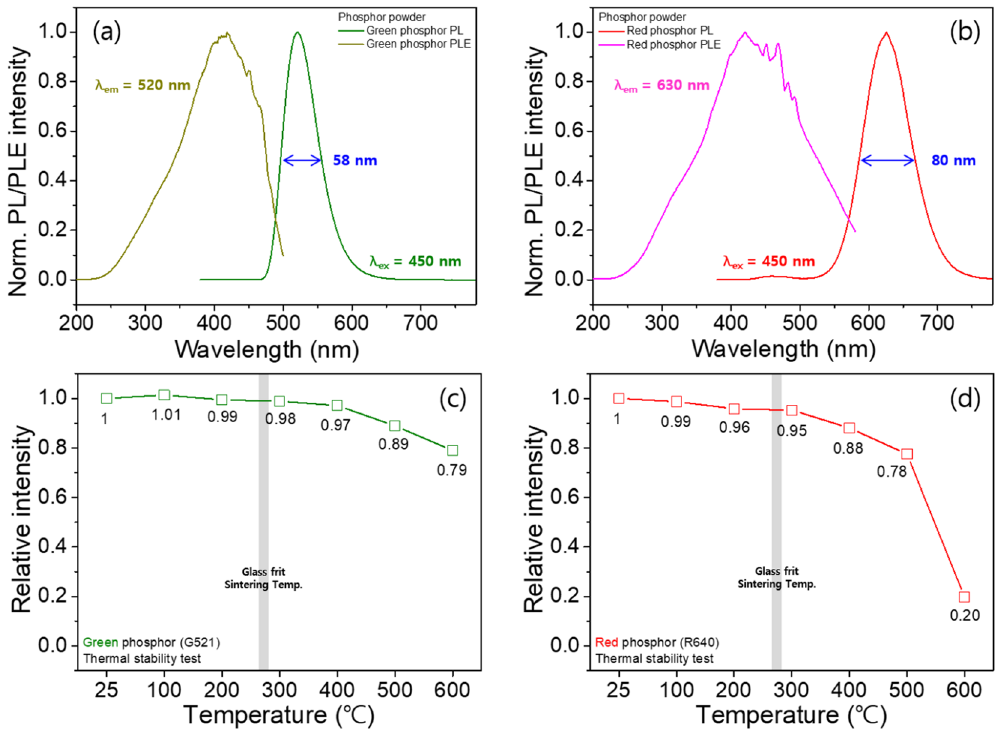
Figure 2. PL and PLE spectra of ( a ) green (BaSr) 2 SiO 4 :Eu 2 + and ( b ) red (SrCa)AlSiN 3 :Eu 2 + phosphors. Relative PL intensity of the temperature dependence of the ( c ) green (BaSr) 2 SiO 4 :Eu 2 + and ( d ) red (SrCa)AlSiN 3 :Eu 2 +